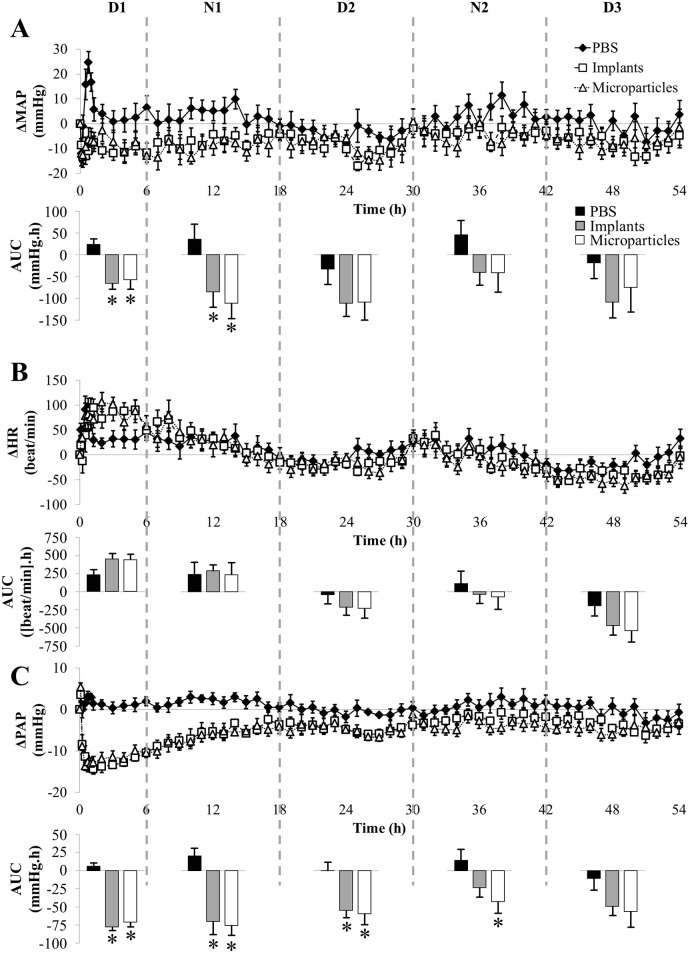
Impact of formulated GSNO at 30 mg/kg on MAP (panel A), HR (panel B) and PAP (panel C).Each animal (n = 7) received all the treatments (Implants: 31.9 ± 0.5; Microparticles 30.9 ± 0.6 mg/kg). Day-night cycles are marked in days (D1, D2 and D3) and nights (N1, N2) periods. For more clarity, after the first hour, only one point for each hour was represented. *: p < 0.05 vs. PBS (one-way ANOVA; post-hoc Bonferroni test).